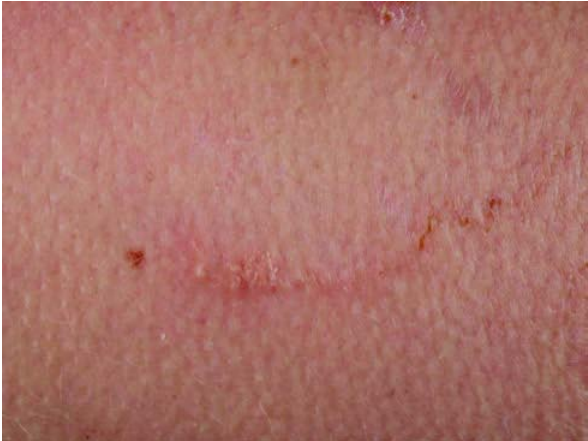
Figure 1: Serpiginous track of cutaneous larva migrans with only moderate inflammatory reaction